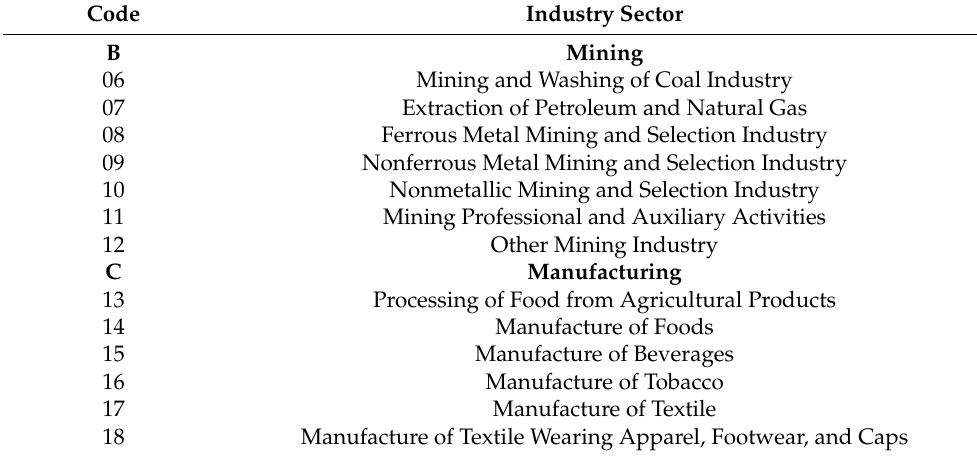
Table A1. A brief description of the subcategorical industrial sectors of mining, manufacturing, and energy industries that have the potential to be detected as industrial heat sources via thermal remote